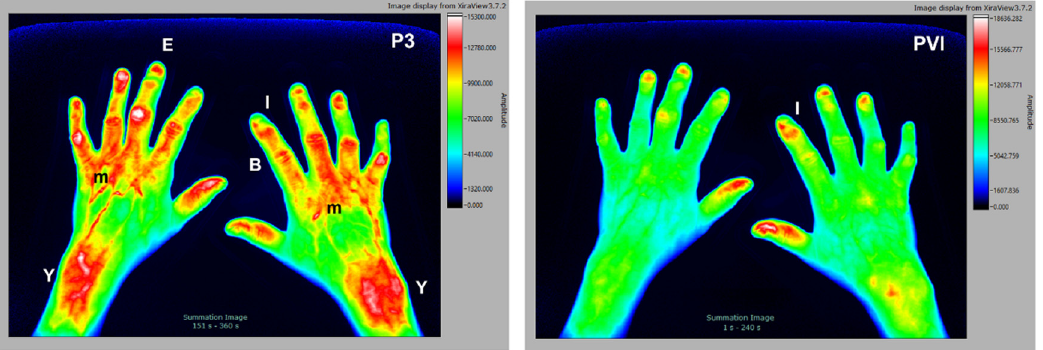
Figure 4. The 59 y/o female patient with clinical diagnosis of fibromyalgia. Signal enhancement seen in muscle–tendon junctions (Y), tendons (B), deeper muscular structures (m), and entheses (E) with irregular nail beds (I).